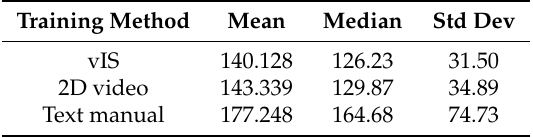
Table 2. Post-training measurement time comparison of all three training methods (in seconds).